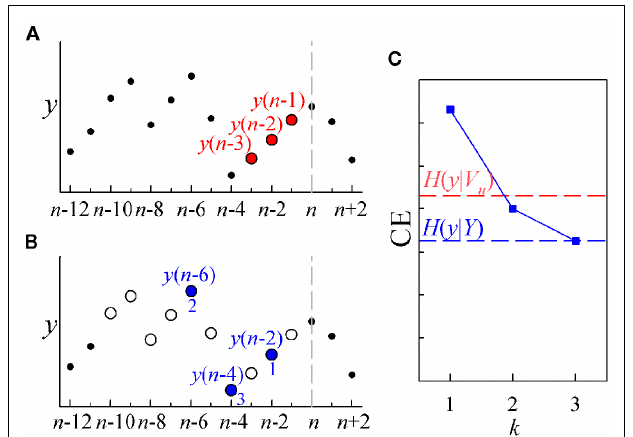
FIGURE 2 | Illustrative example of CE computation for a representative short sequence of a time series y (dots), with overlapped the terms exploited for uniform conditioning [(A), red] and for non-uniform conditioning [(B), blue]; in (B), empty circles denote the set of initial candidate terms, while filled circles denote selected terms, with the number indicating the step k at which selection occurred; the vertical dashed lines mark the current time sample n . (C) CE computed after uniform conditioning [ H ( y | V u ), red dashed line] and after non-uniform conditioning [ H ( y | Y ), blue dashed line]; the CE computed at each step k of the sequential procedure for non-uniform conditioning is indicated by blue